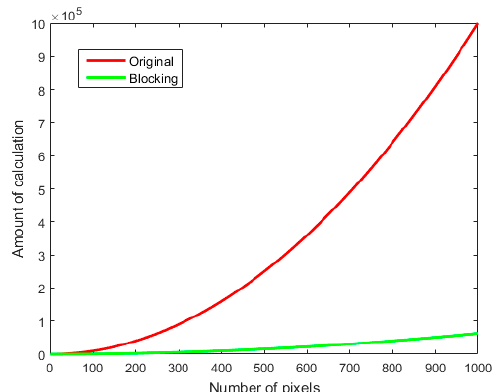
Figure 9. Computational complexity of speckle reduction anisotropic diffusion (SRAD) before and after blocking.